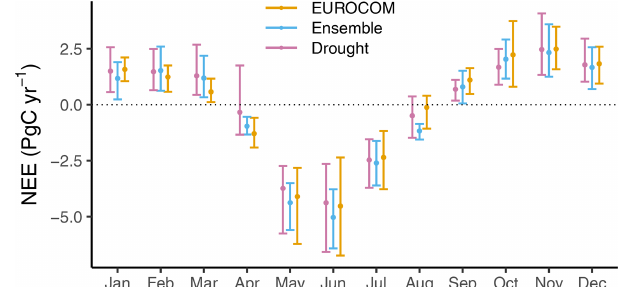
Figure 9. Comparison of monthly NEE estimates calculated as the mean of six inversions taken from Monteil et al. (2020), denoted as “EUROCOM”; eight inversion members conducted in our study (se- tups listed in Table 2), denoted as “Ensemble”; and five inversions used in Thompson et al. (2020) for the 2018 drought study, denoted as “Drought”. The error bars refer to the spreads (min/max) over the respective members amid each ensemble of